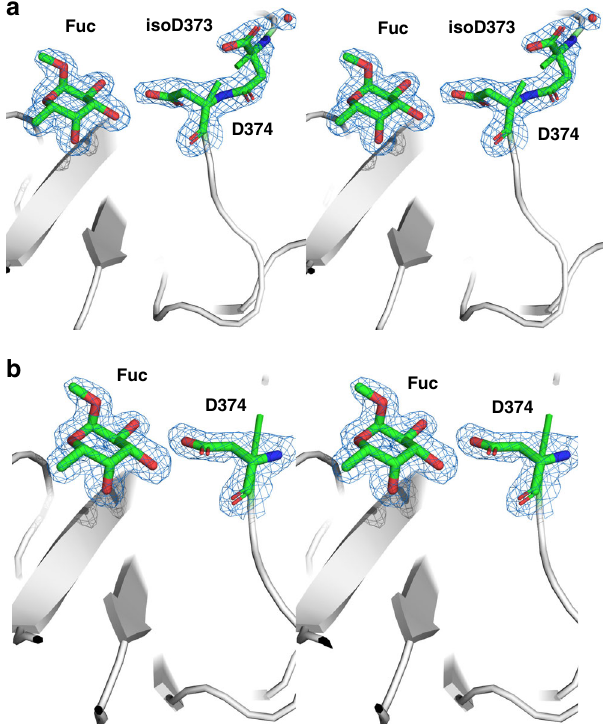
Fig. 7 Binding of methyl α - L -fucopyranoside to deamidated GII.4 Saga P- dimers. Wall-eyed stereo representation of the crystal structure showing a non-canonical binding mode of methyl α - L -fucopyranoside in the modi fi ed binding pocket. The 2 F O − F C map is shown ( σ level = 1.0). a For one chain the isopeptide bond (isoD373) and the ligand are clearly visible. b For the other chain the loop bordering the binding pocket is unstructured N-terminally of D374, and a canonical binding mode is